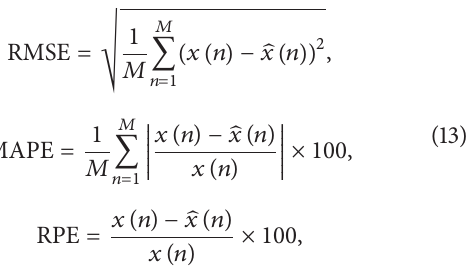
absolute percentage error (MAPE), and relative percentage error (RPE), which are calculated as